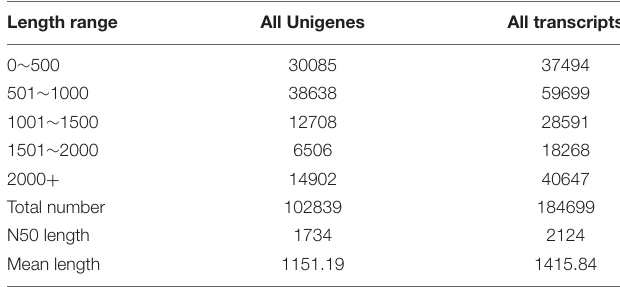
TABLE 4 | Summary of Unigenes identified in brain samples of the two Sinocyclocheilus species.